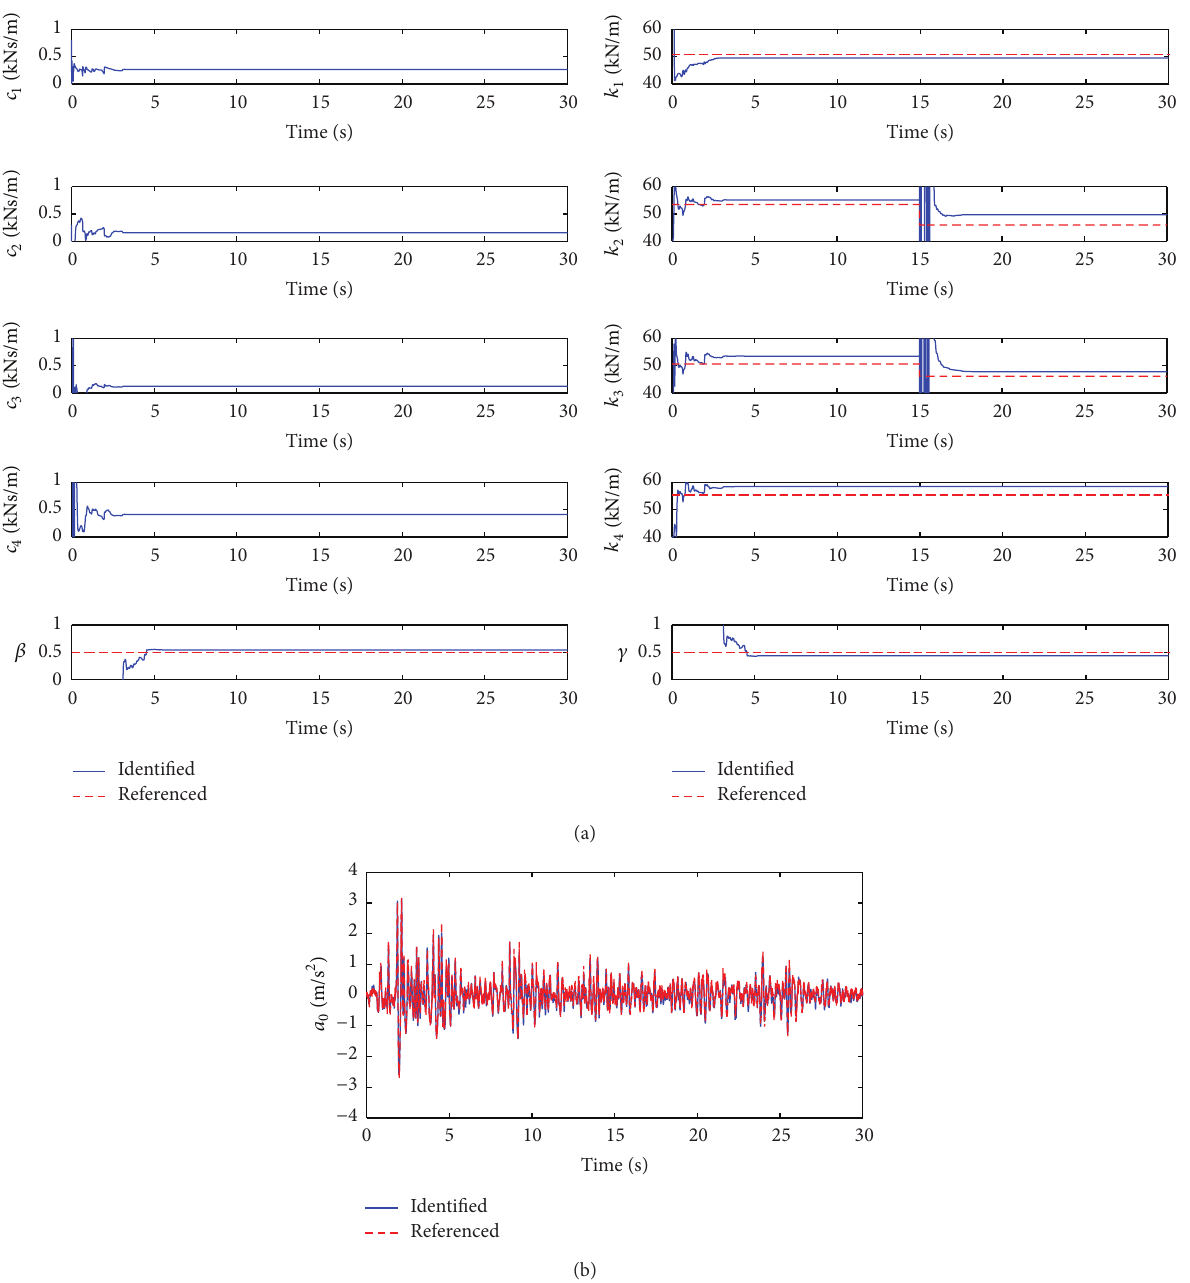
Figure 10: Identified results for Case 3: (a) identified parameters; (b) identified